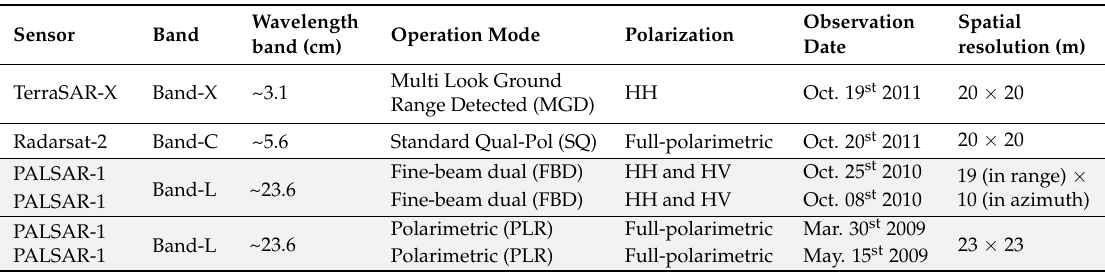
Table 1. Characteristics of SAR data.